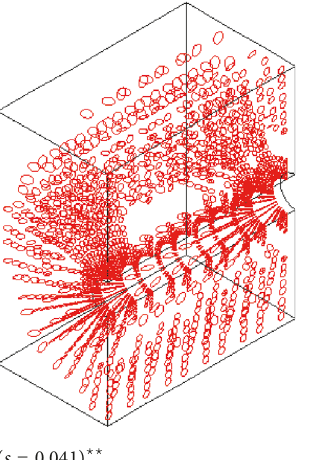
Figure 13: Displacement resulting from corrosion-induced expan- sion = 0.041 mm.